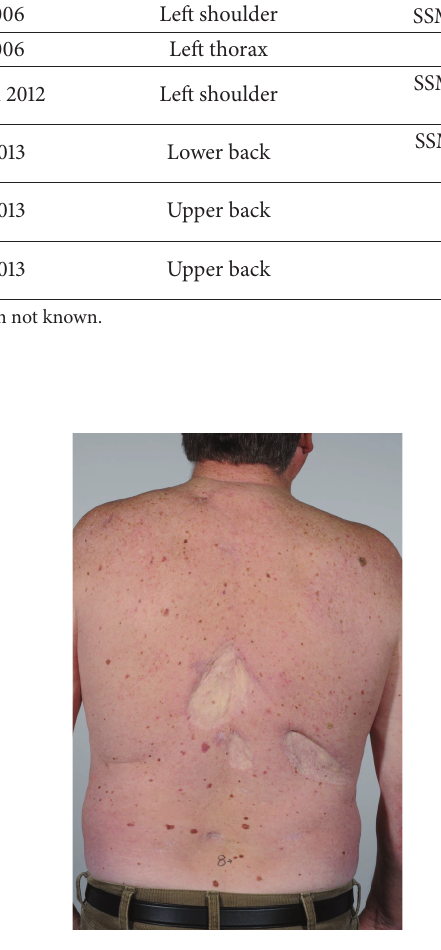
Figure 1: Patient with 11 melanomas over 32 years, showing areas with skin grafts due to previous treatment for melanoma as well as multiple dysplastic